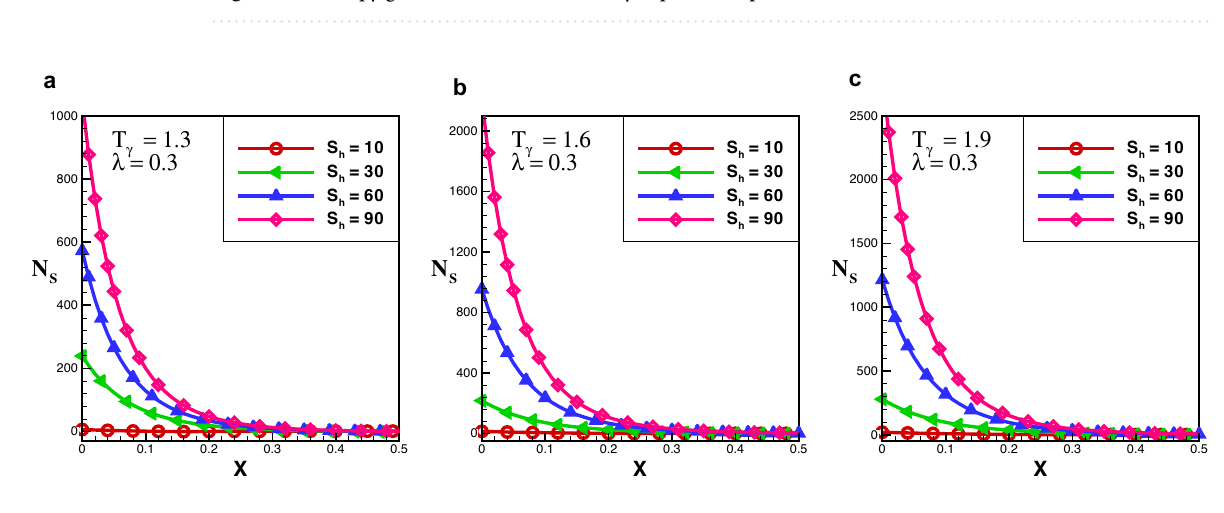
Figure 7. Entropy generation number in decay exponential porous fin for (cid:31) = 1 .